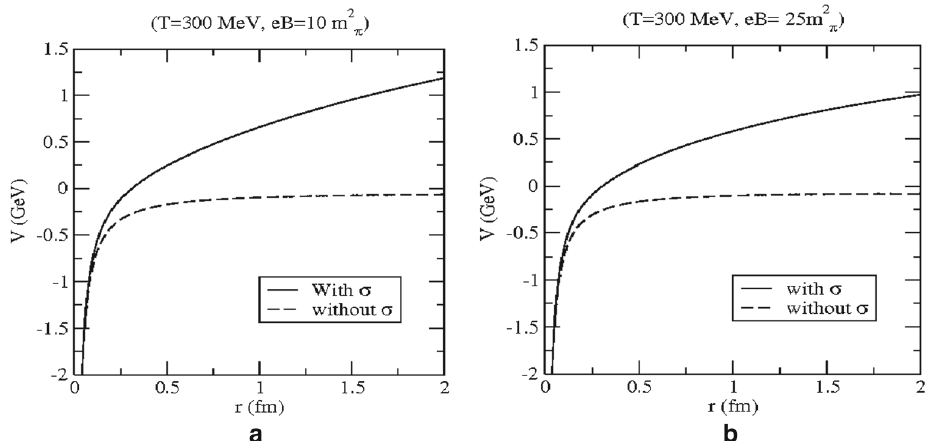
Fig. 4 The effect of string term on potential is depending on the magnetic field